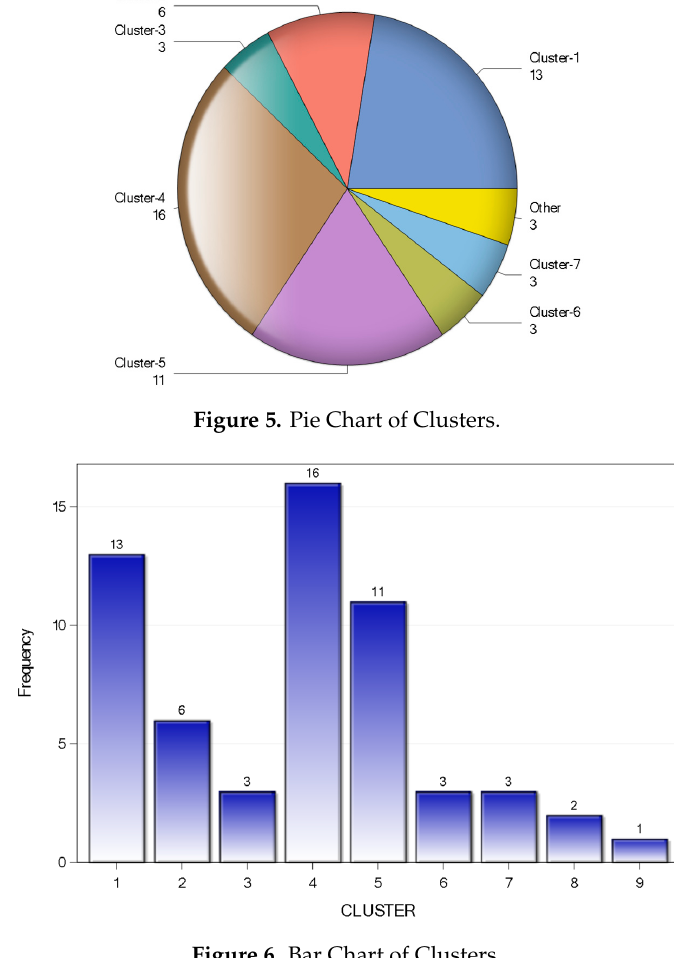
Figure 6. Bar Chart of Clusters.